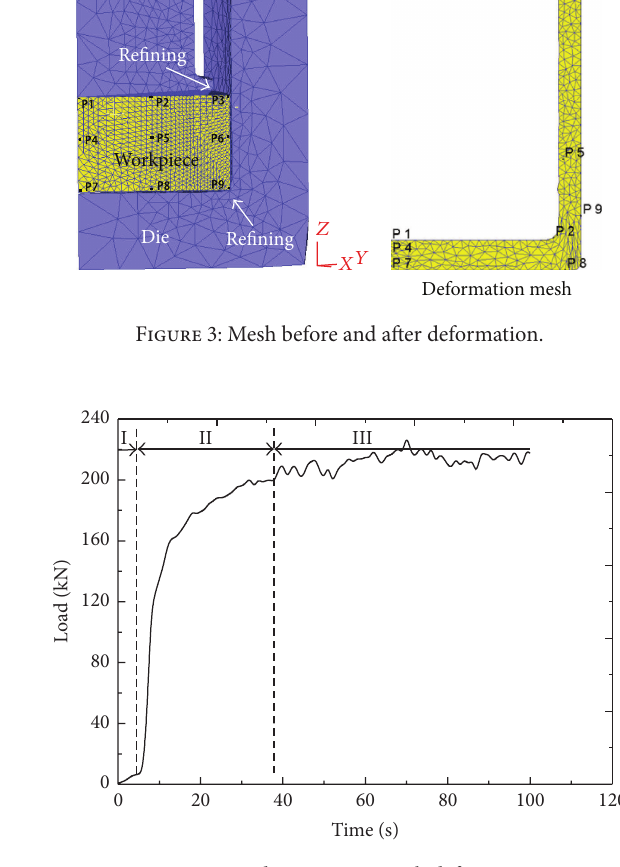
Figure 4: Load-time curves with